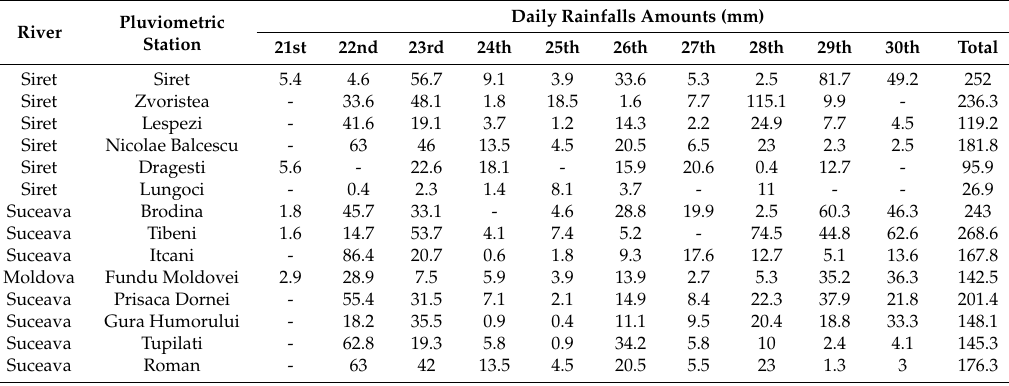
Table 3. Daily rainfalls between 21 and 30 June 2010 in the Siret river basin.